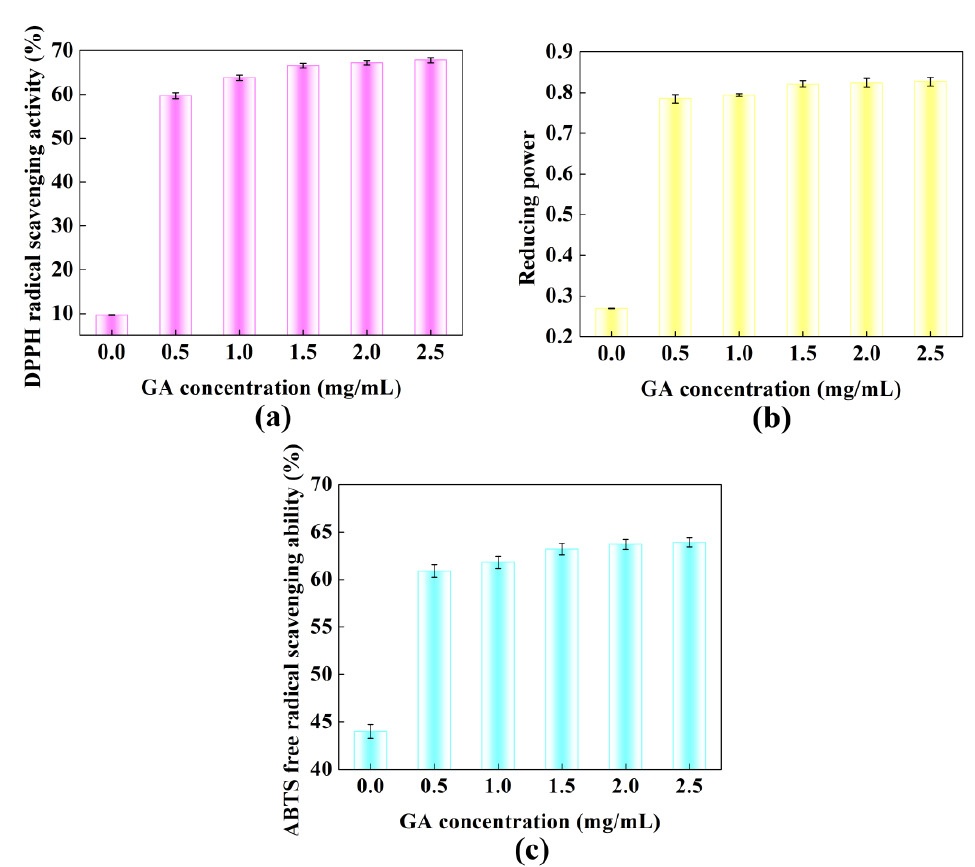
Figure 5. Antioxidant abilities of Pv–GA complexes. (a) DPPH radical scavenging; (b) reducing power ability; (c) ABTS + radical scavenging.